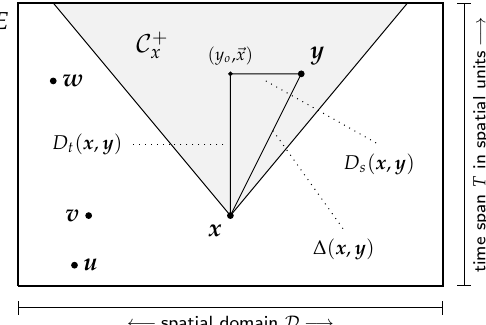
Figure 3. A geometrical interpretation of ∆ : ∆ ( x , y ) is the hypotenuse of the triangle formed by D s ( x , y ) and D t ( x , y ) if y ∈ C + x . For all the other events / ∈ C + x the distance is infinte. For example: ∆ ( x , u ) = ∞ because u ∆ ( x , v ) = ∞ because v ∆ ( x , w ) = ∞ because D < x = x s ( x , w ) > 0 0 , 0 0 and kD t ( x , w ) even if w 0 > x 0